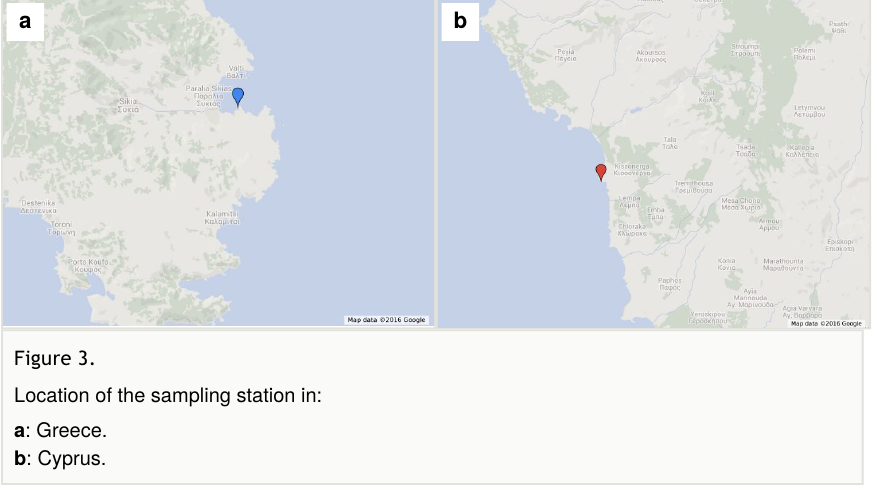
Linaraki : The sampling site is located on the peninsula of Sithonia, in the North Aegean Sea (Fig. 3a). It is a moderately exposed rocky shore with a photophilic algal assemblage dominated by Ellisolandia elongata .